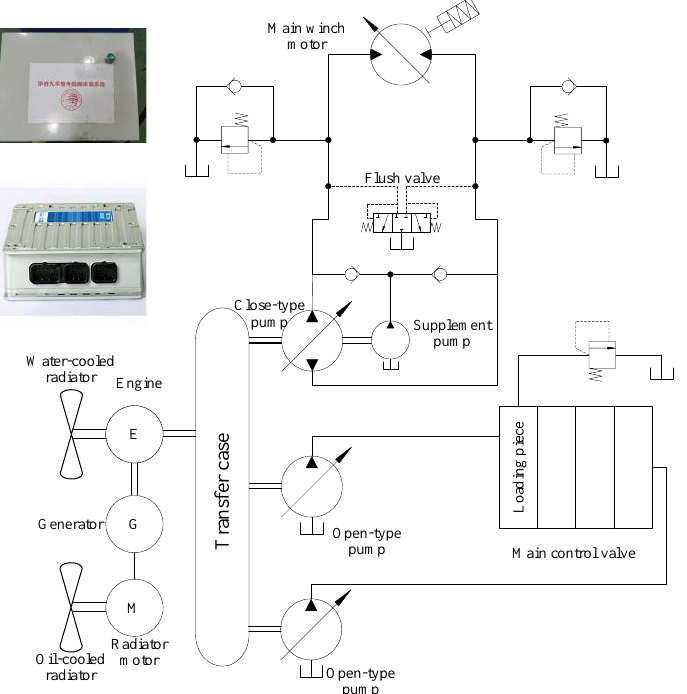
Figure 1. Hydraulic energy storage and driving schematic diagram of the winch lifting system. In Equation (1), the external load torque transferred to the winch motor by heavy load accounts for the largest proportion. During the working process, the energy con- sumed to overcome the weight of gravity also accounts for a large proportion. Using the hydraulic balance energy storage principle of the four-quadrant pump/motor, and by set- ting the appropriate displacement of the four-quadrant pump/motor, which can work in pump or motor mode, the drag torque that the weight loaded on the winch motor can be mostly balanced by the four-quadrant pump/motor. Meanwhile, the excess drag torque is balanced by the open-structure part which is the coaxial transmission with the four-quad- rant pump/motor through the transfer case. Namely